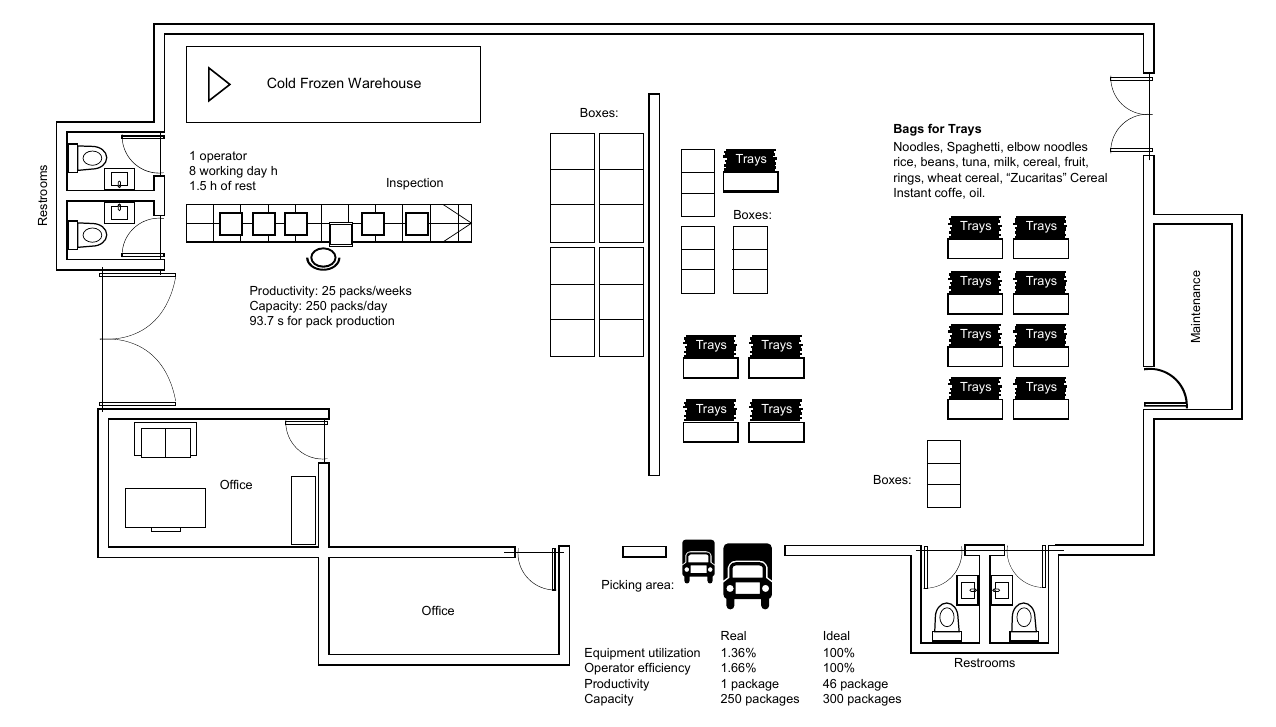
Figure 3. Packing process mapping.